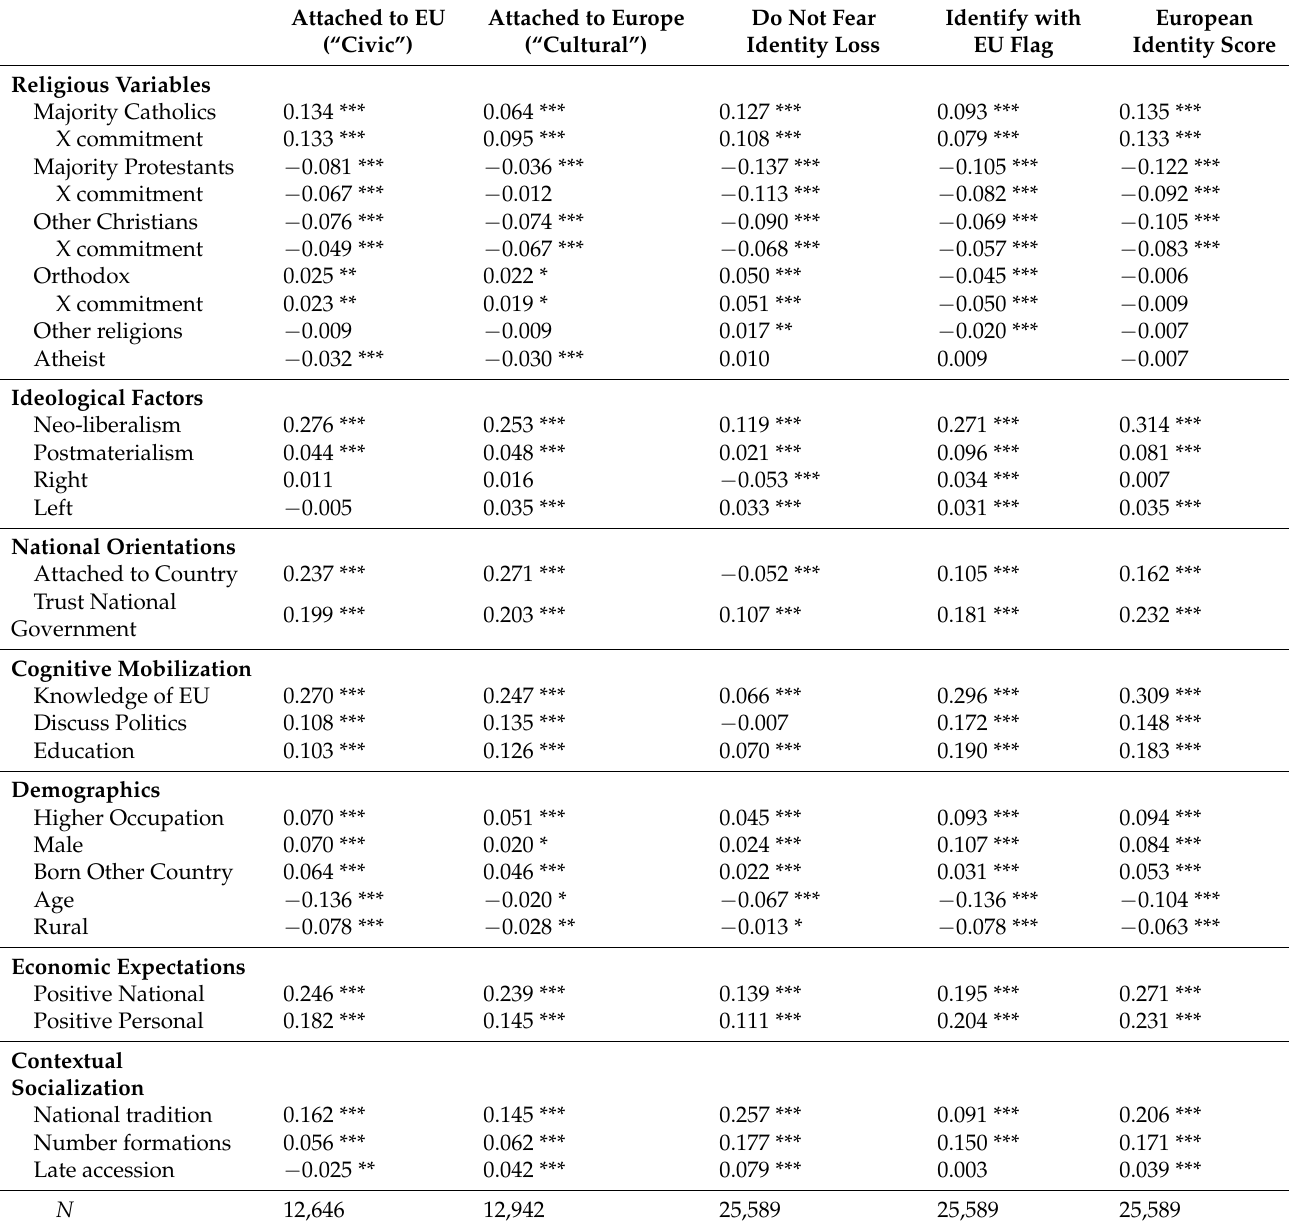
Table 1. Correlates of Alternate Measures of European Identity (Pearson’s r